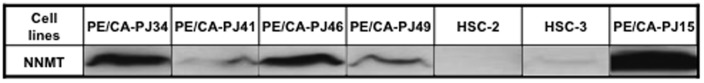
Western blot analysis of NNMT.50 µg of protein obtained from 7 human cancer cell lines were transferred from 15% SDS-PAGE to polyvinylidene fluoride membranes. Blot was probed with anti-NNMT antibody, and detected with enhanced chemiluminescence.